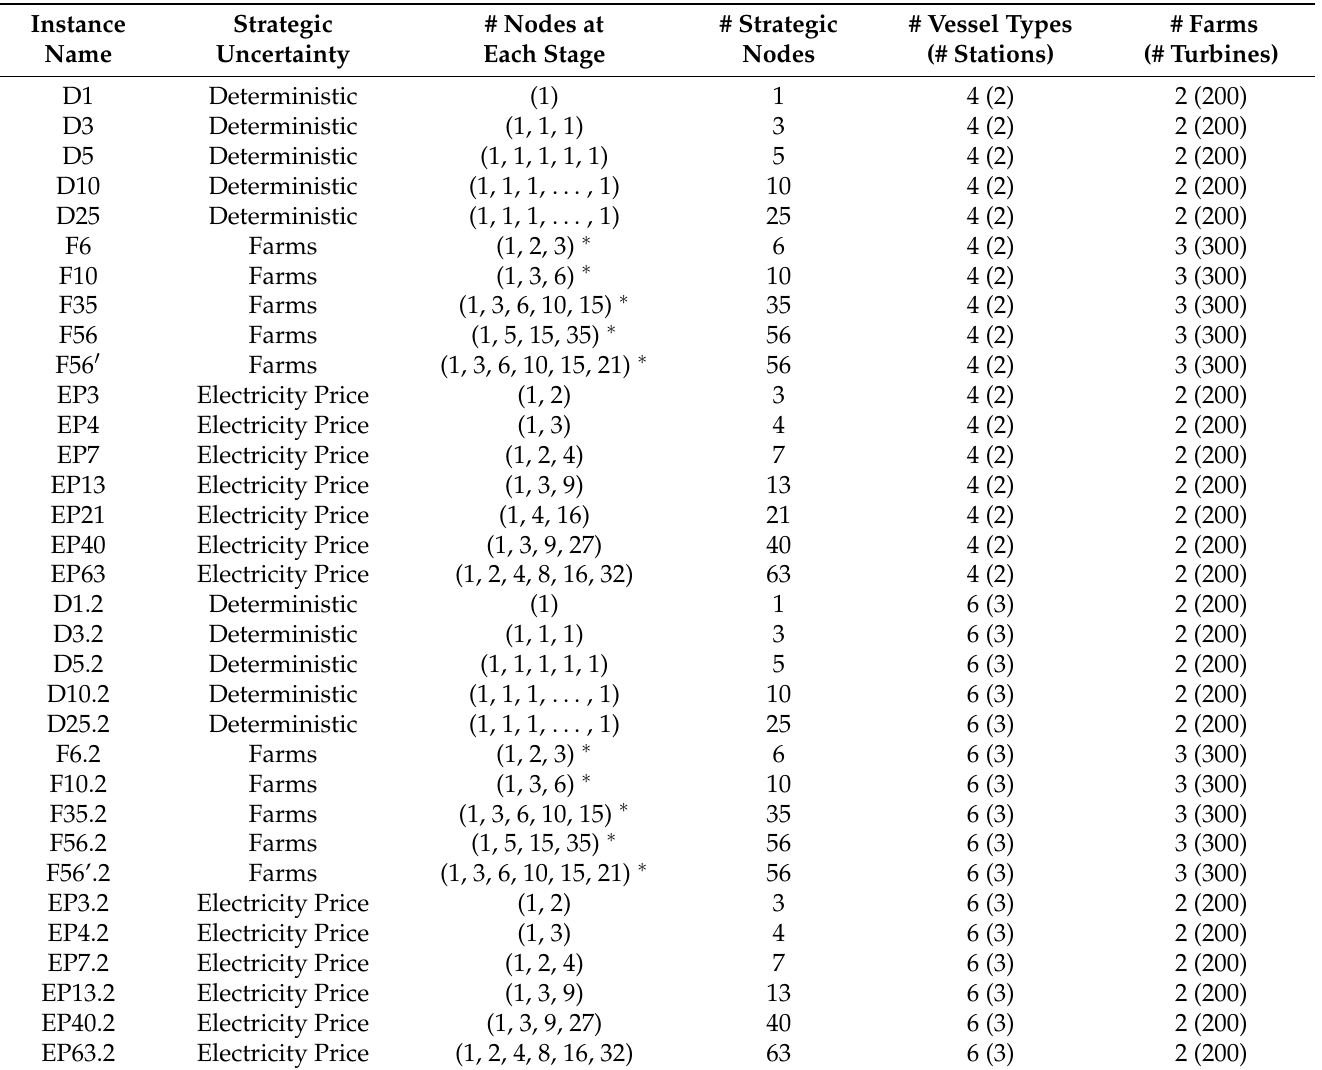
Table 3. Test instances used in the performance testing. The strategic scenario trees for instances marked with an asterisk are unbalanced. Their structure is explained in